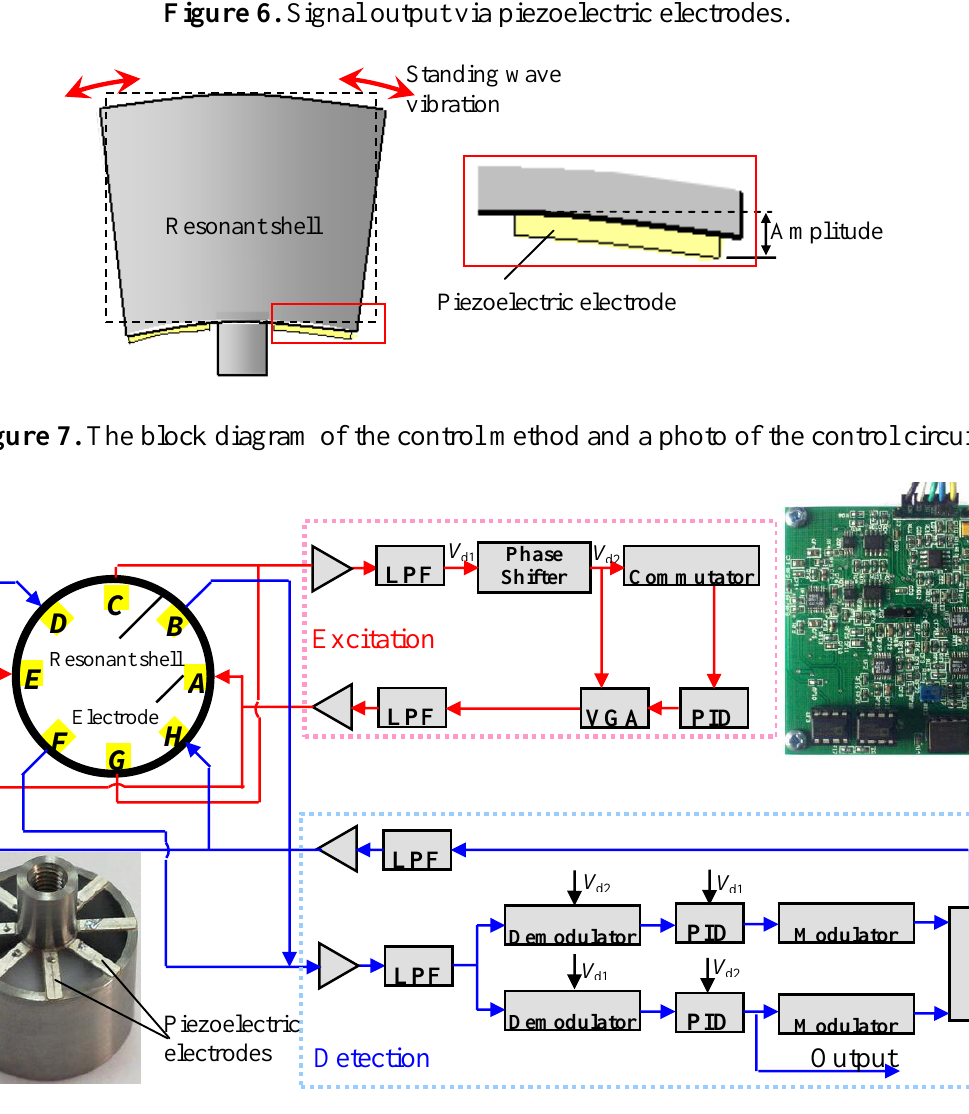
Figure 6. Signal output via piezoelectric electrodes.